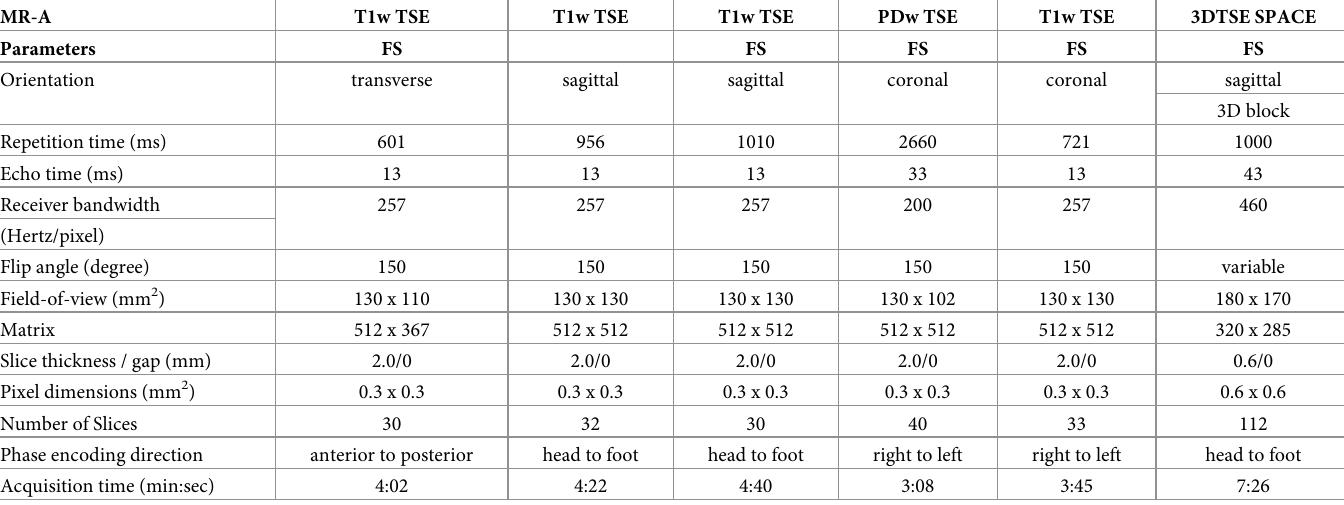
Table 1. MR scan